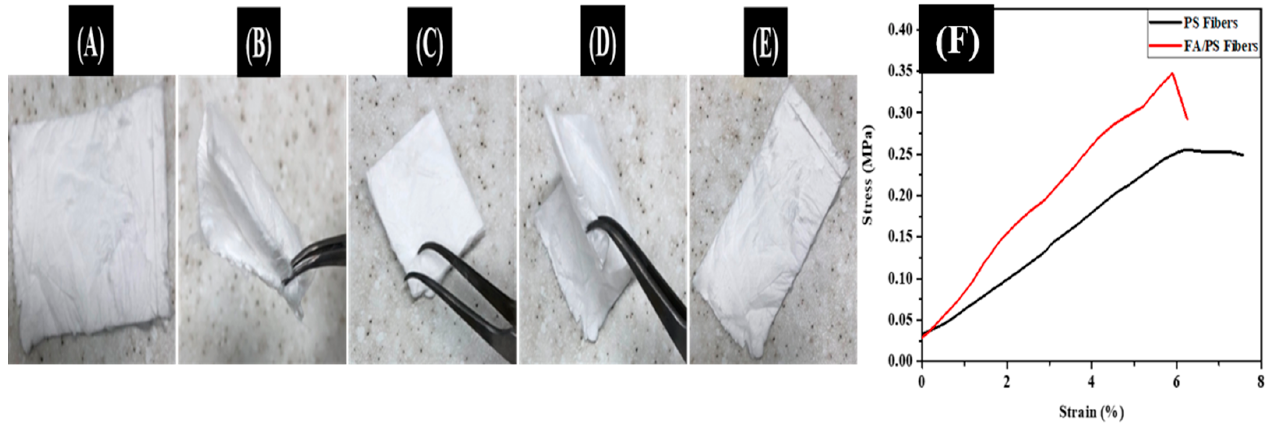
Figure 5. ( A ) Optical images of as-prepared FA/PS membrane, ( B ) during folding, ( C ) folded with 180°, ( D ) during unfolding, and ( E ) after unfolding. ( F ) is the stress–strain curve of the as-prepared FA/PS fiber membrane compared to PS fiber membrane.